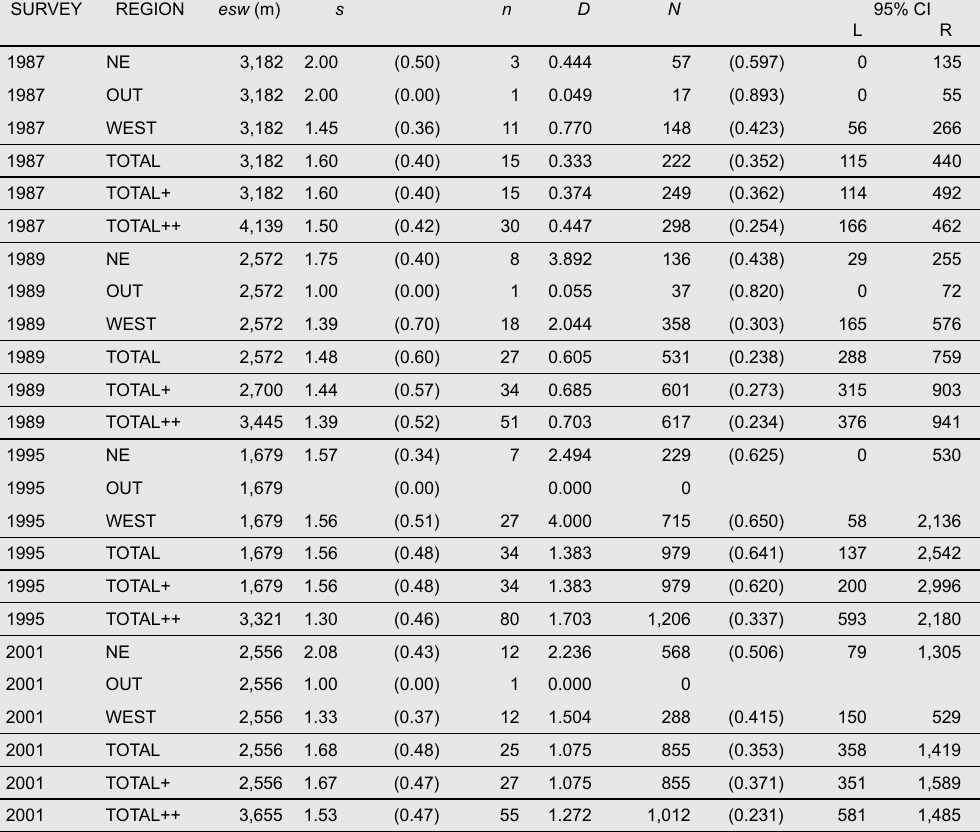
Table 2. Characteristics of abundance estimates for blue whales from the NASS. esw – effective strip half-width, averaged over all covariates; s – mean group size; n – number of sightings; D – density (no. per 1,000 nm 2 ); N – abundance.